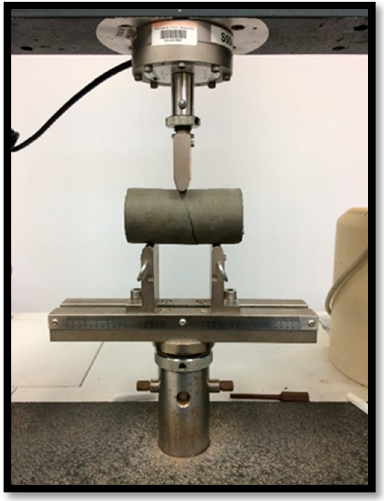
Figure 1. Three-point bending test.